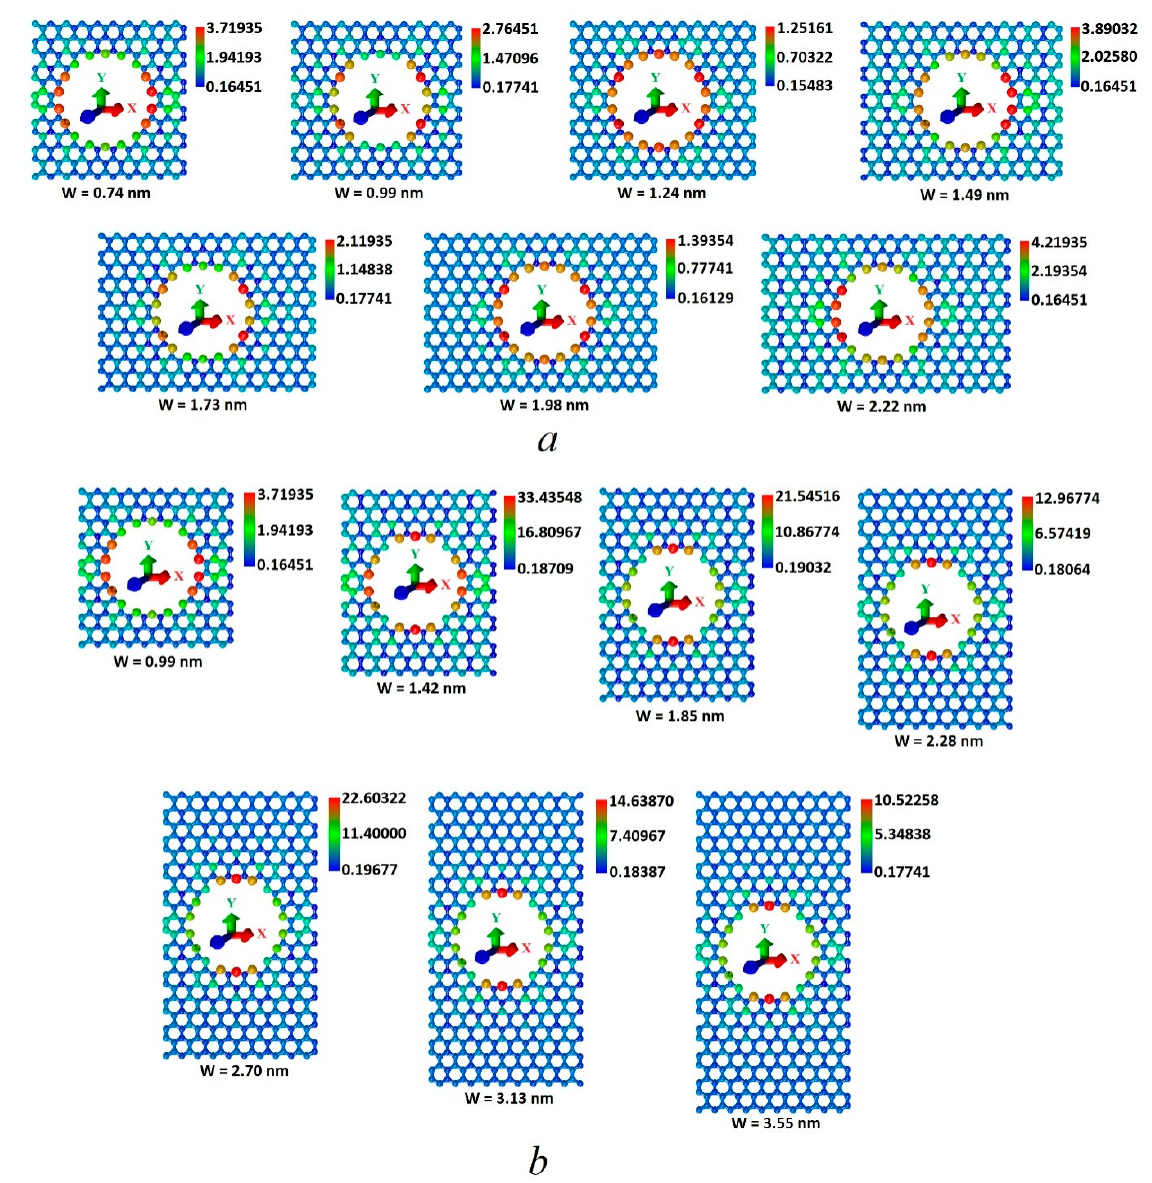
Figure 3. Maps of the HG’s LDOS distribution in the case of the neck width increasing along the zigzag ( a ) and armchair ( b ) directions (in LDOS units of a pure graphene atom).